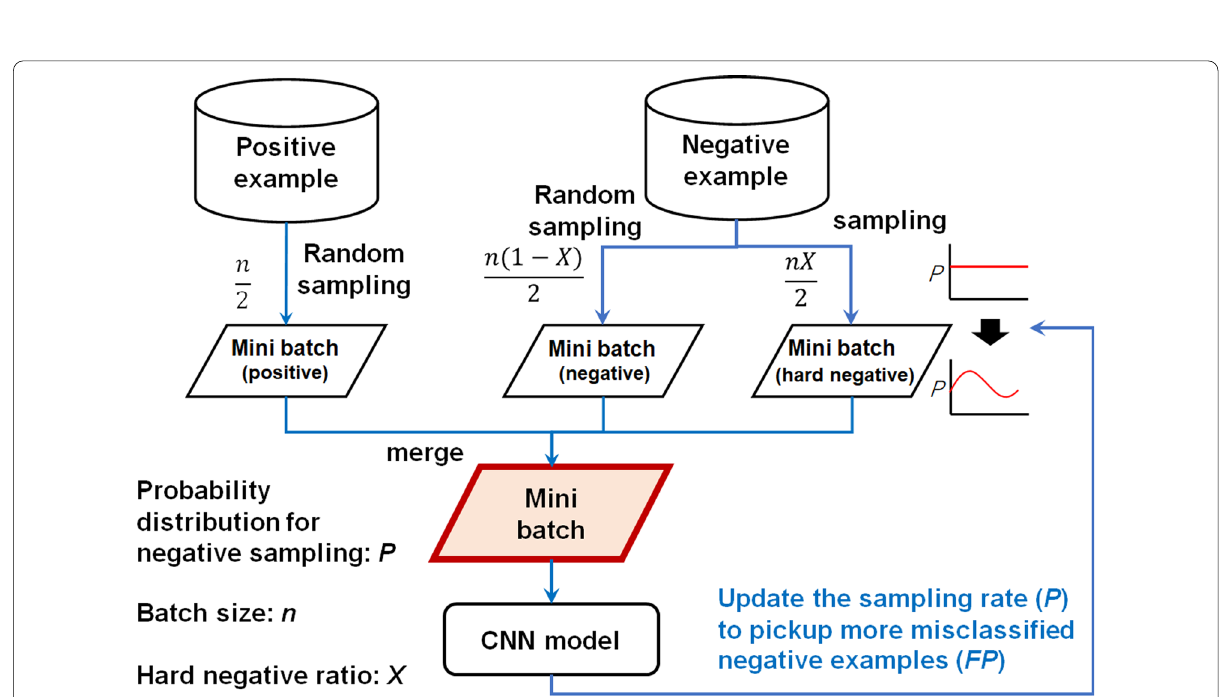
Fig. 4 Undersampling of the majority class using hard negative